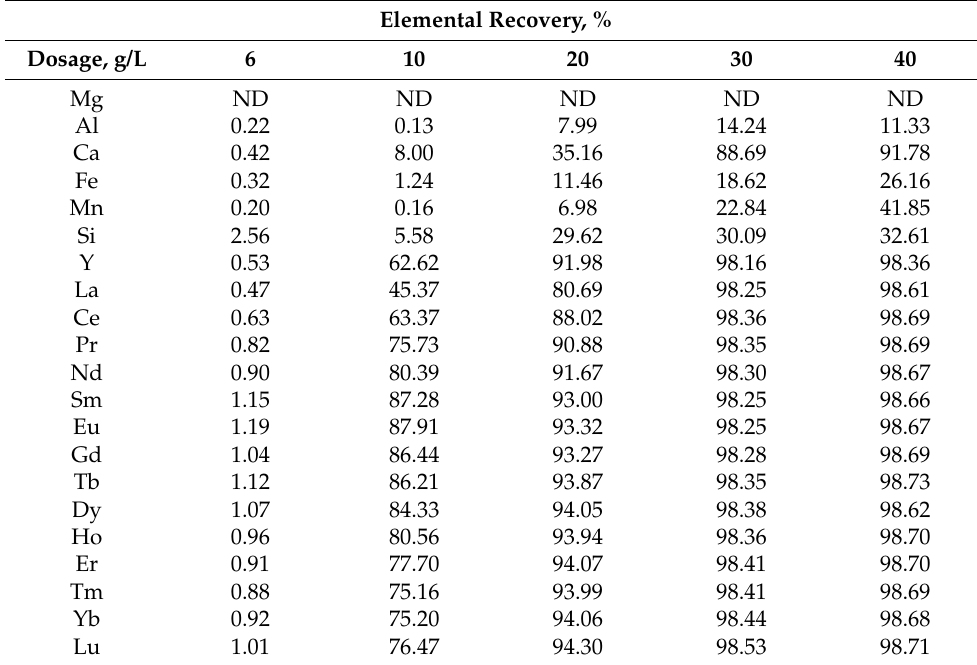
Table 7. Elemental recovery of rare earth elements and contaminants (Al, Ca, Fe, Mn, Si) at a fixed pH of 1.5 and reaction time of 2